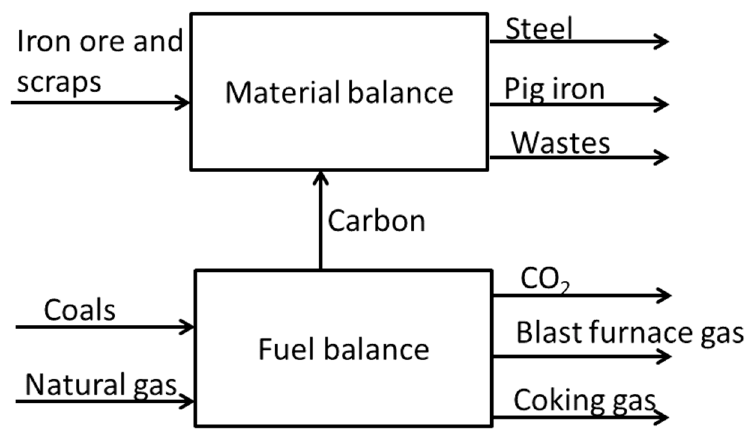
Figure 1. Scheme of the calculation of carbon stored in the products from iron and steel